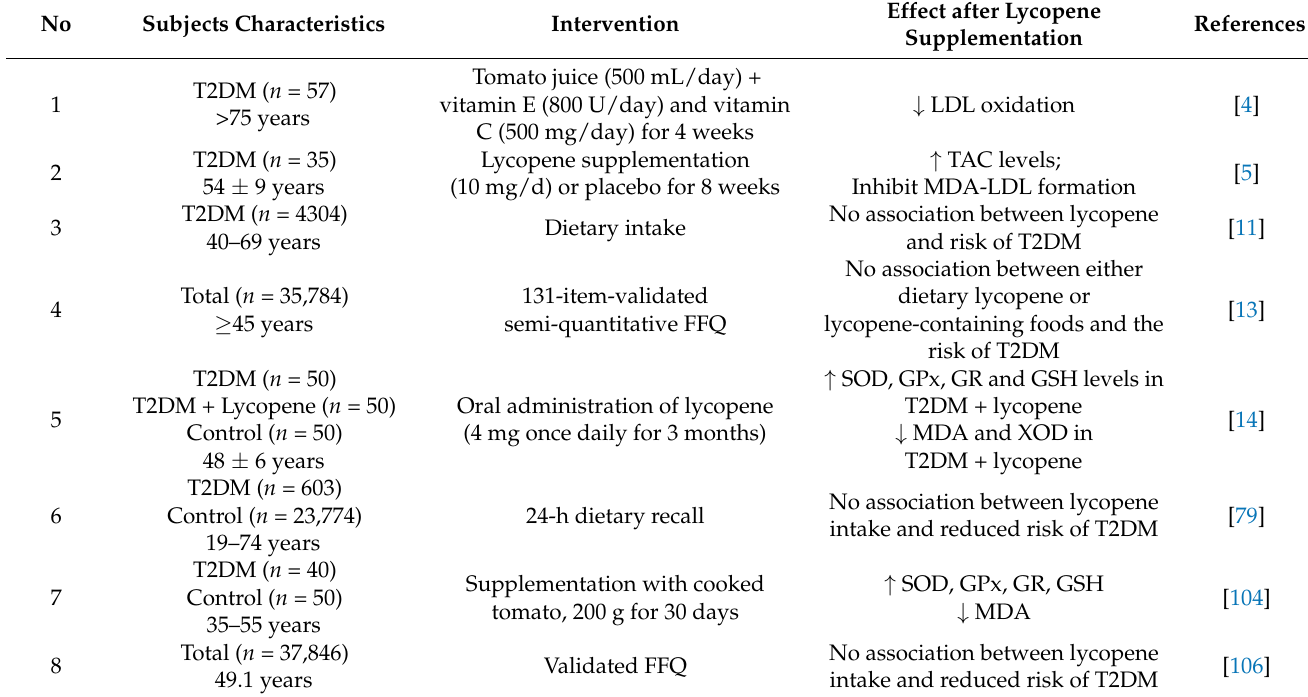
Table 7. Human studies on the effect of lycopene on oxidative stress and risk of